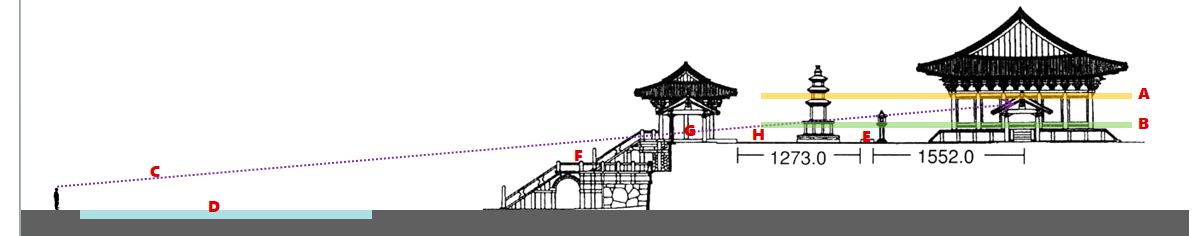
Figure 13. Ritual Concept at Bulguksa Temple (Kim 2011). A: Height of Buddha Image; Location of Sarira Casket; B: Height of the West Pagoda’s Foundation; Height of the Main Hall’s Foundation; C: Human Angle (10 to 15 degrees) from the Lotus Pool (Nine Ranks for Rebirth); D: Lotus Pool (Pond); E: Worship Stone (Bongnodae); F: Flat Stone Platforms; G: Gate (Jahamun); H: Flat Platform with Enclosure Pure Land.